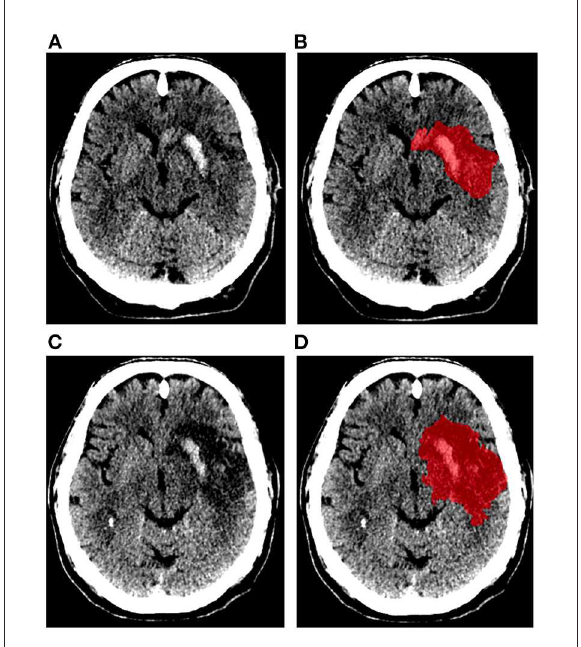
FIGURE1 Example of ischemic lesion segmentation (represented in red). Non-contrast CT scans and segmentation of ischemic lesion obtained after 24h (A,B) , and 1 week (C,D) of stroke onset.